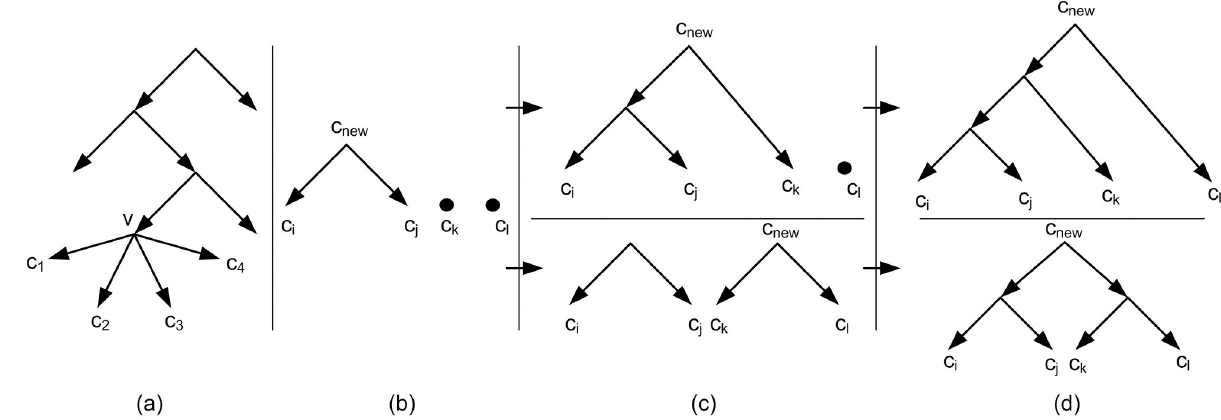
Fig 17. SPR is used to obtain six different structures from a given tree structure. (a) The structure that is obtained by merging c i , c j and connecting them to a new node c Ð c ri , c li Ð c lj , c li Ð c rj ,